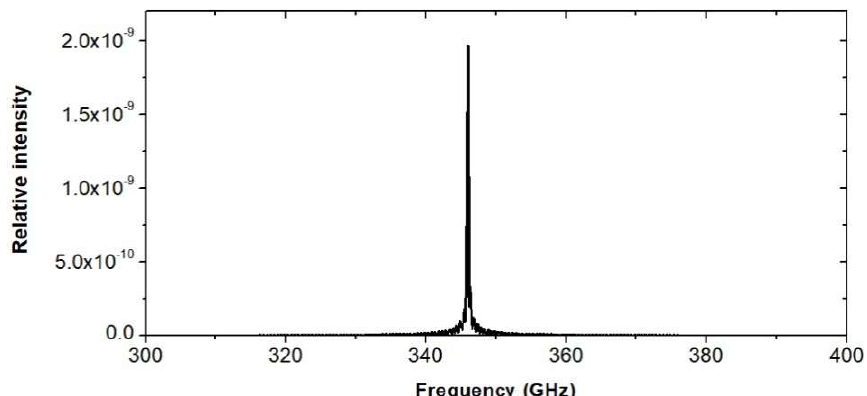
Figure 10. The Fourier transform of output signal at 346 GHz.